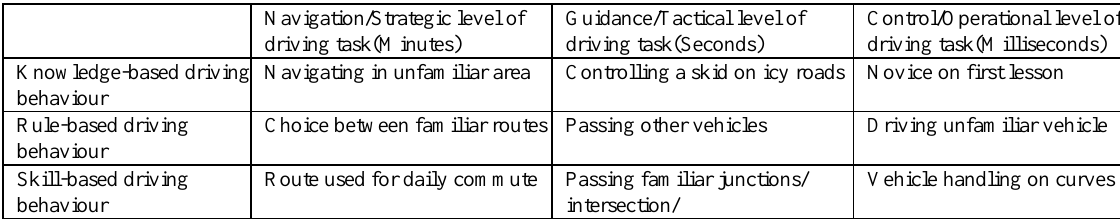
Table 1 Classification of selected driving